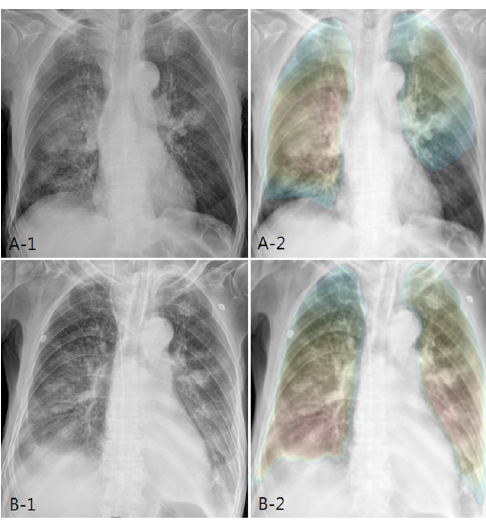
Fig 5. AI probability score changes and heatmap in aggravated patient. (a) In an 81-year-old male patient, initial chest X-ray shows bilateral patchy increased opacity, compatible with pneumonia. AI pneumonia model (A-2) shows the probability score of 0.833 and color map for pneumonia. (b) After 7 days of treatment, the chest X-ray shows slight aggravation. AI pneumonia model (B-2) shows slight increase of probability score (0.876) and increased extent of color map for pneumonia.